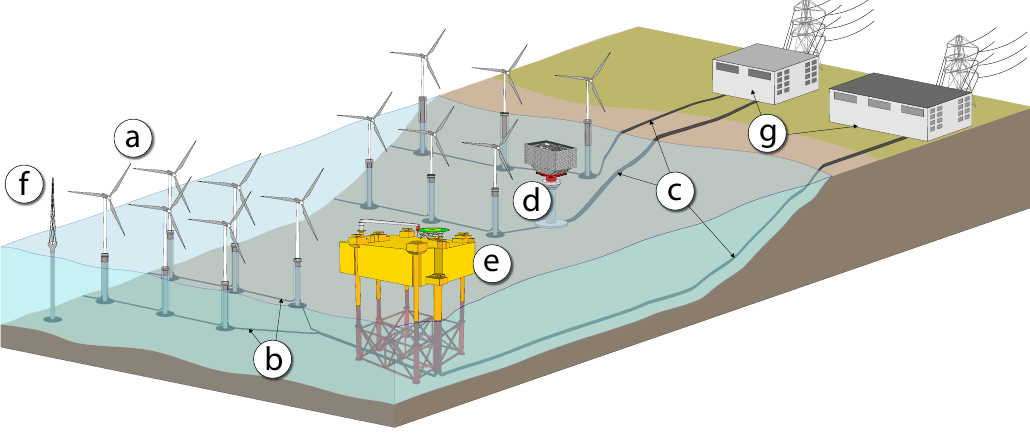
Figure 6. Main components of an OWF: ( a ) Wind turbines; ( b ) Collection cables; ( c ) Export cables; ( d ) Transformer station; ( e ) Converter station; ( f ) Meteorological mast; ( g ) Onshore stations.